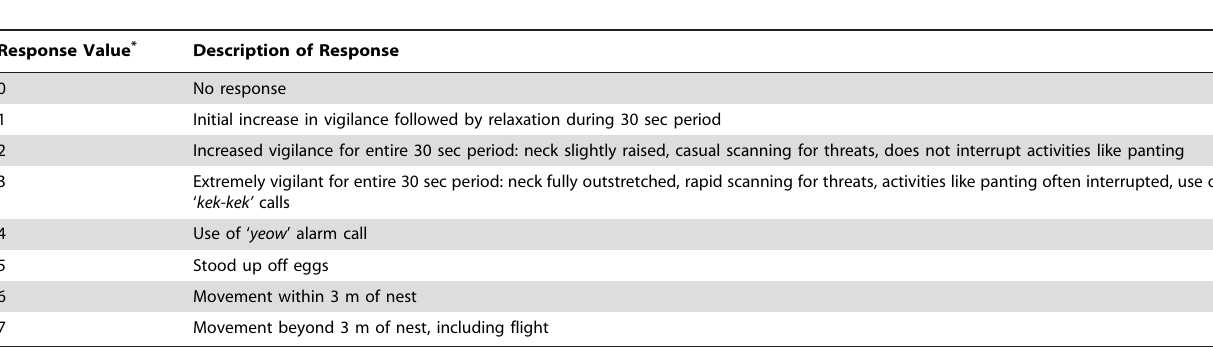
Table 1. Categorical values used to rate the overall reaction of gulls to auditory and visual